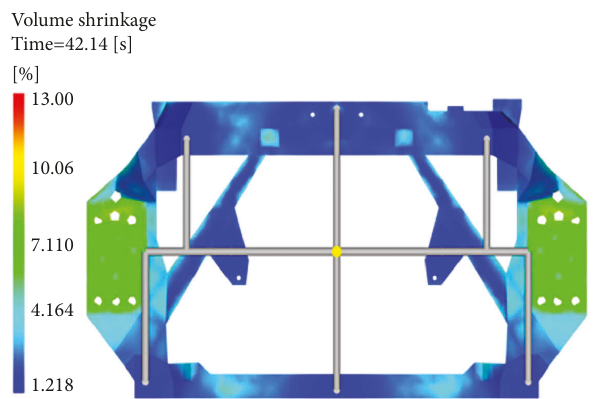
Figure 28: Cloud image of volume shrinkage.